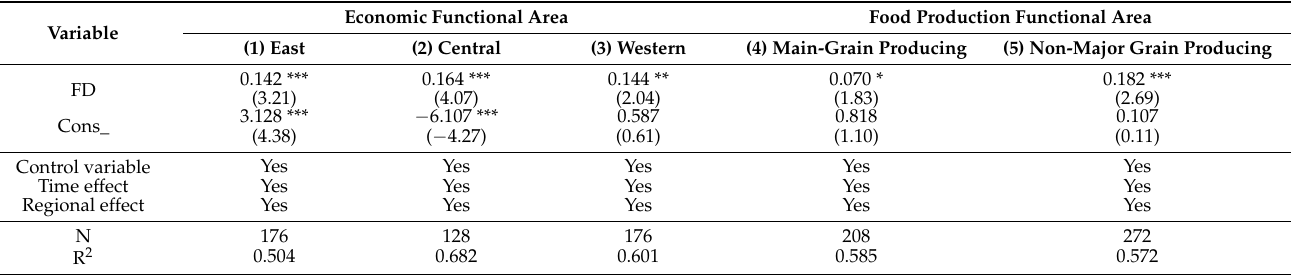
Table 7. Heterogeneity test